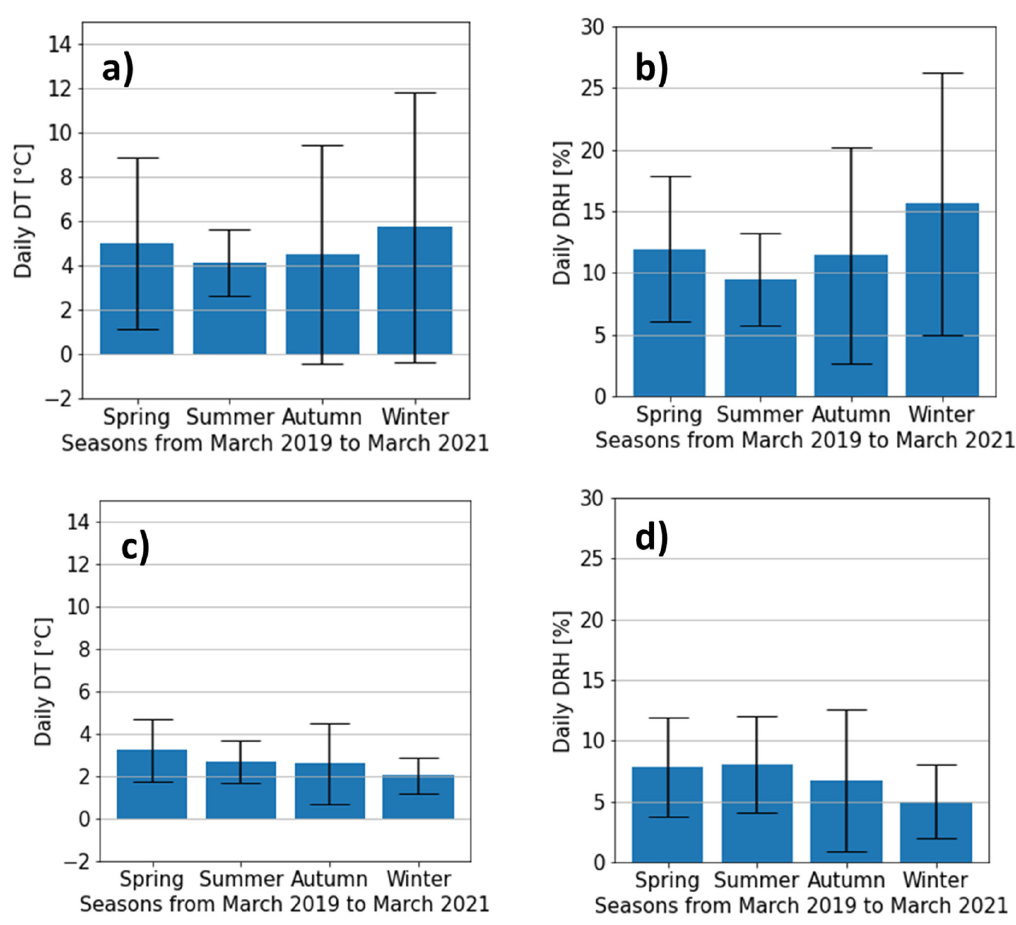
Figure 3. Bar plots of daily RH range and daily T for Ringebu church ( a , b ) and for Heddal church ( c , d ). The height of the bars is the average value for the considered daily range during one of the four seasons, while the black line is the standard deviation.